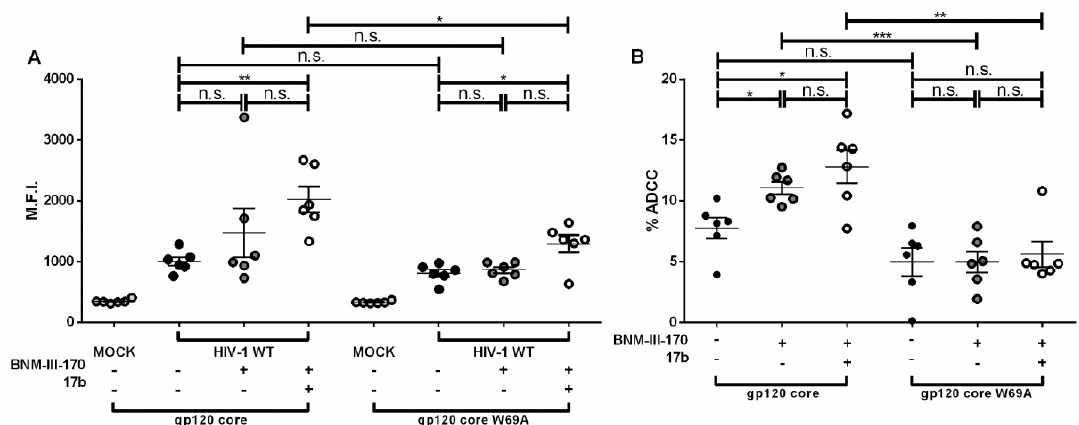
Figure 4. Anti-Cluster A and anti-CoRBS Abs are required to mediate ADCC in the presence of the CD4mc BNM-III-170. ( A ) Staining of primary CD4 + T cells infected with NL4.3 ADA GFP WT using immunized guinea pig sera (1:1000 dilution). ( B ) ADCC quantification against primary CD4 + T cells infected with NL4.3 ADA GFP WT using autologous PBMCs in presence of immunized guinea pig sera (1:1000 dilution). Results are the mean of at least three independent experiments. Bars represent the standard error of the mean. Di ff erences within groups were compared using paired t-test or Wilcoxon test depending on normality distribution. Di ff erences between groups were compared using Mann-Whitney U test. (n.s., not significant; * p ≤ 0.05; ** p ≤ 0.01; *** p ≤ 0.001). ( − ): Without preincubation. ( + ): With preincubation. M.F.I.: Mean fluorescence intensity.